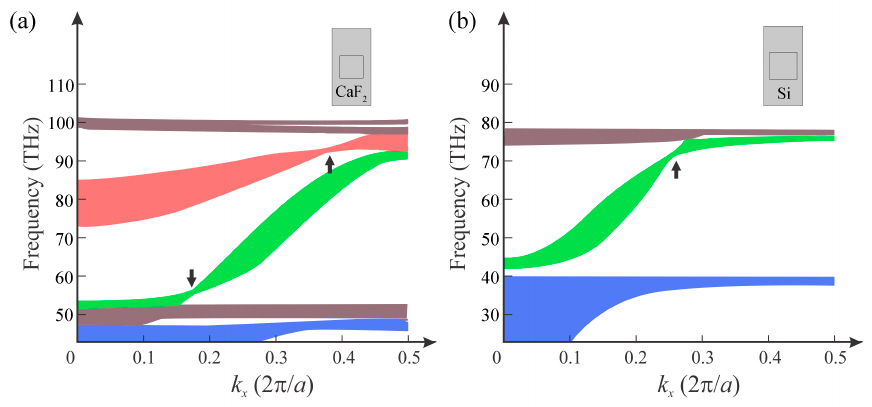
Figure 8. Band structures of the PHC with ( a ) CaF 2 matrix and ( b ) Si matrix.